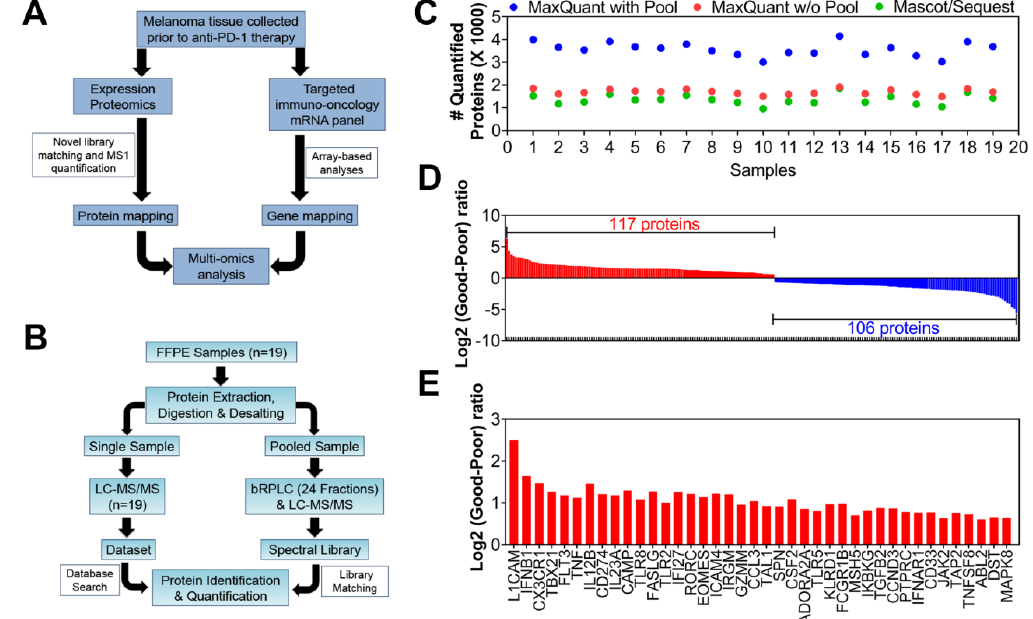
Figure 1. Identification of differentially expressed genes and proteins associated with a favorable response to anti-PD-1 therapy. ( A ) Schematic of the multi-omics pipeline to analyze formalin-fixed, paraffin-embedded (FFPE) samples collected prior to anti-PD-1 therapy in melanoma patients. ( B ) Flow chart describing the library matching process used to significantly increase the identification of unique peptides. ( C ) Scatter plot illustrating the advantage of using library matching to quantify more protein groups by LC–MS/MS across all 19 FFPE samples. ( D ) Two group analyses of proteomics and genomics data were performed on log 2 transformed and normalized signals. Averages were calculated for each group then subtracted to yield log 2 ratios. Student’s t-tests (two-sided, unequal variance) and Hellinger distances were calculated to create a score to be used in the informatics pipeline to compare good (progression-free survival (PFS) >1 year) vs poor (PFS <1 year) responders. Two hundred twenty-three differentially expressed proteins (upregulated = blue/downregulated = red) were found in the MaxQuant output based on |log 2 ratio| ≥ log 2 (1.5-fold change), t-test p value < 0.05, and Hellinger distance > 0.25. ( E ) A similar 2 group analysis was then performed on the targeted-mRNA dataset. Forty differentially expressed mRNAs (upregulated = blue) were found based on |log2 ratio| ≥log2(1.5-fold), t-test <0.05, and Hellinger distance >0.25 (Table S3).